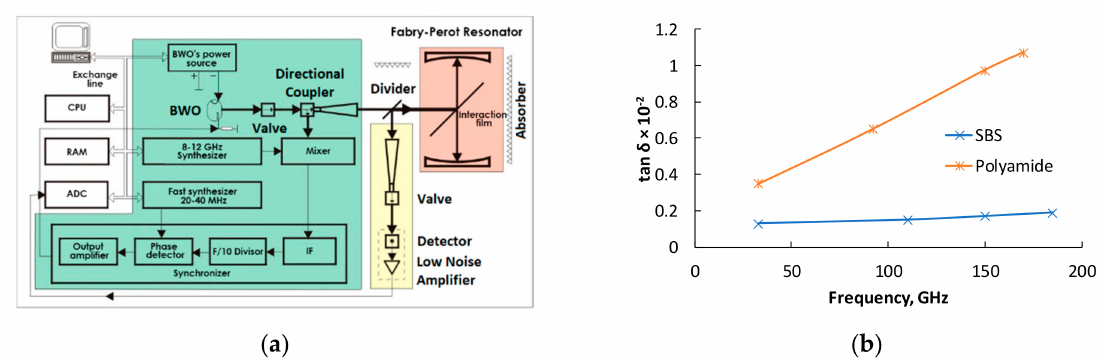
Figure 2. ( a ) The scheme of measurement of dielectric properties with the test sample in the form of the disk in the quasioptical resonator; ( b ) loss tangent of the SBS and